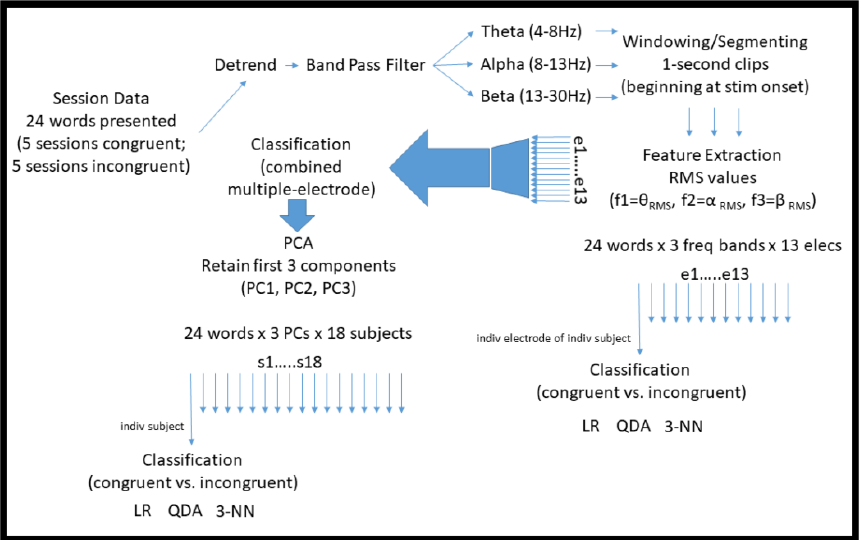
Figure 3. Diagram illustrating the main computational techniques used to pre-process and classify the raw EEG data in the initial analysis methodology described in Sections 2.3.1 – 2.3.6. raw EEG data in the initial analysis methodology described in Sections